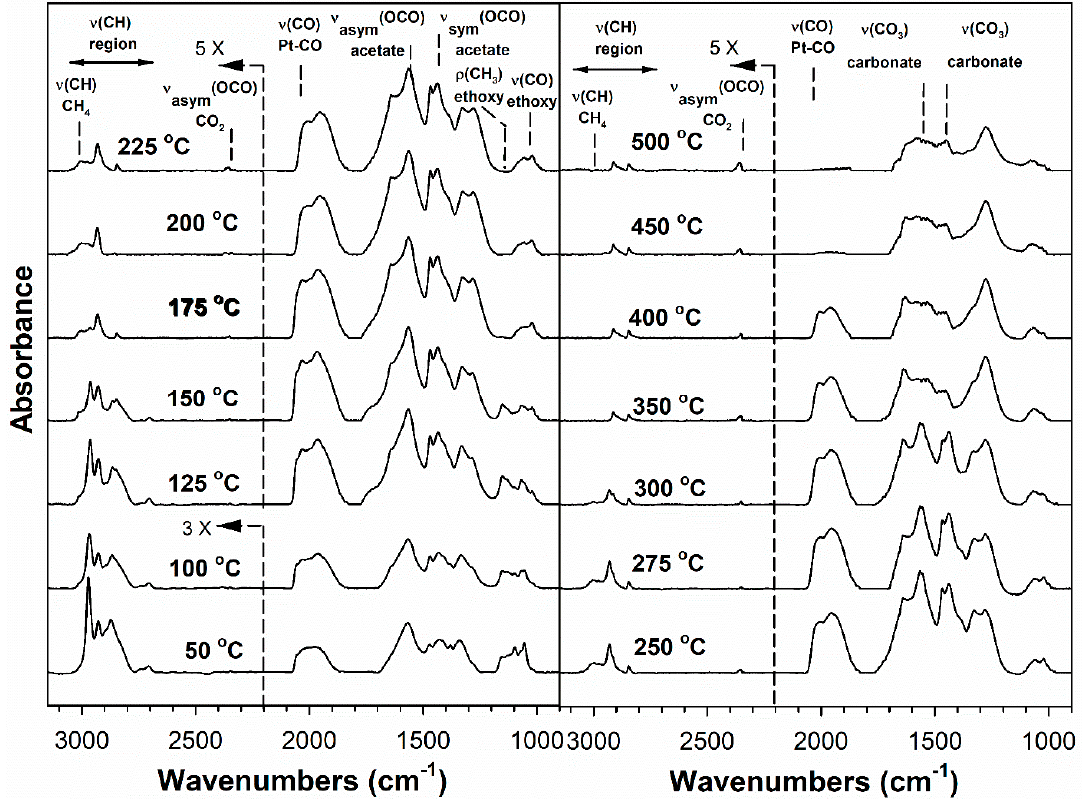
Figure 5. DRIFTS of transient ethanol steam reforming over 2.9% Cs-2% Pt/ZrO 2 .